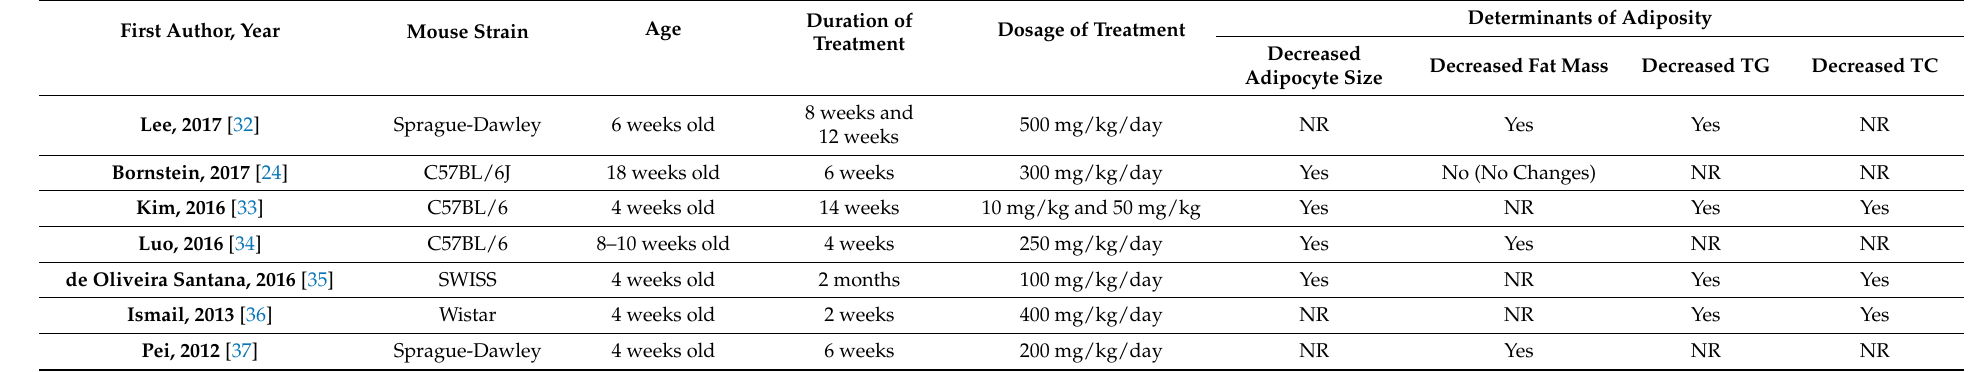
Table 3. Summary of studies that reported on the effects of metformin on adiposity in animal models with type 2 diabetes